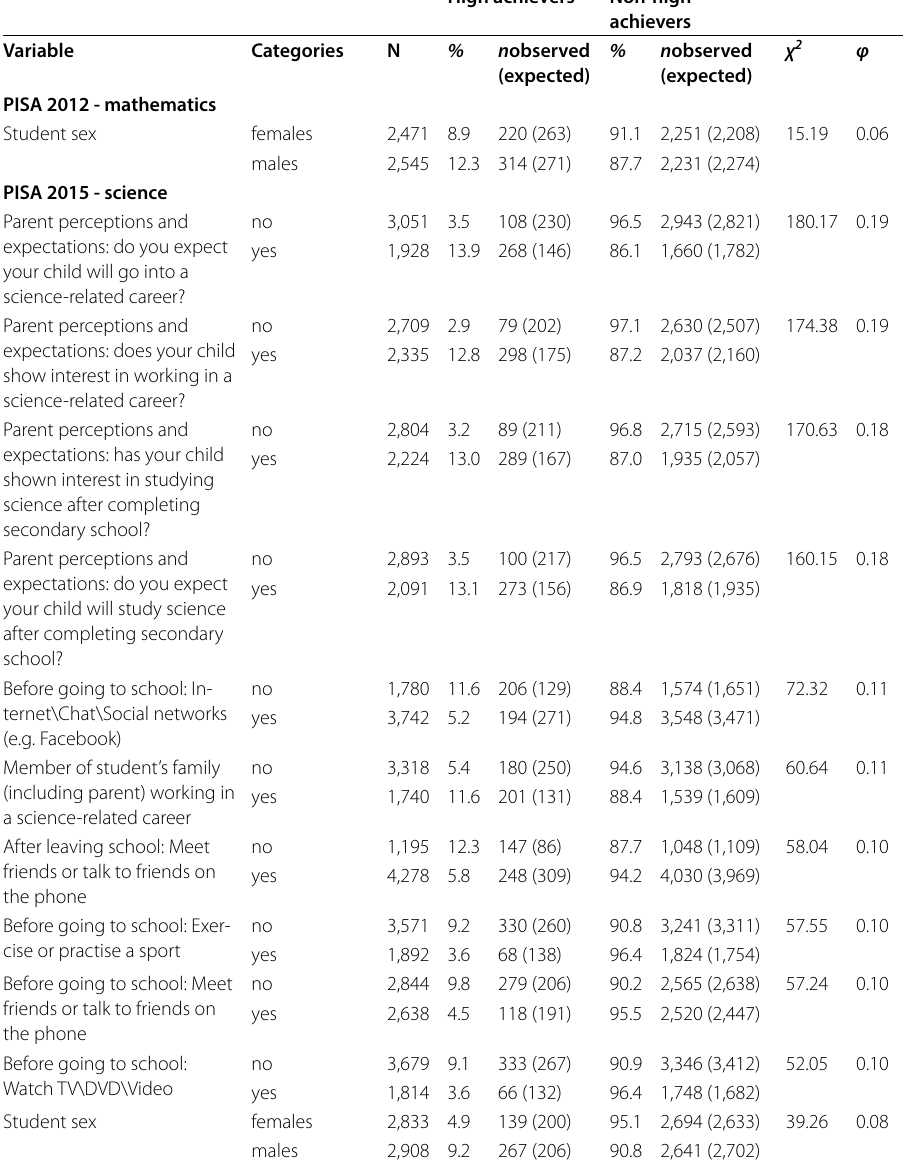
Table 1 Distribution of students across nominal background variables by performance group Variable Categories N % n observed